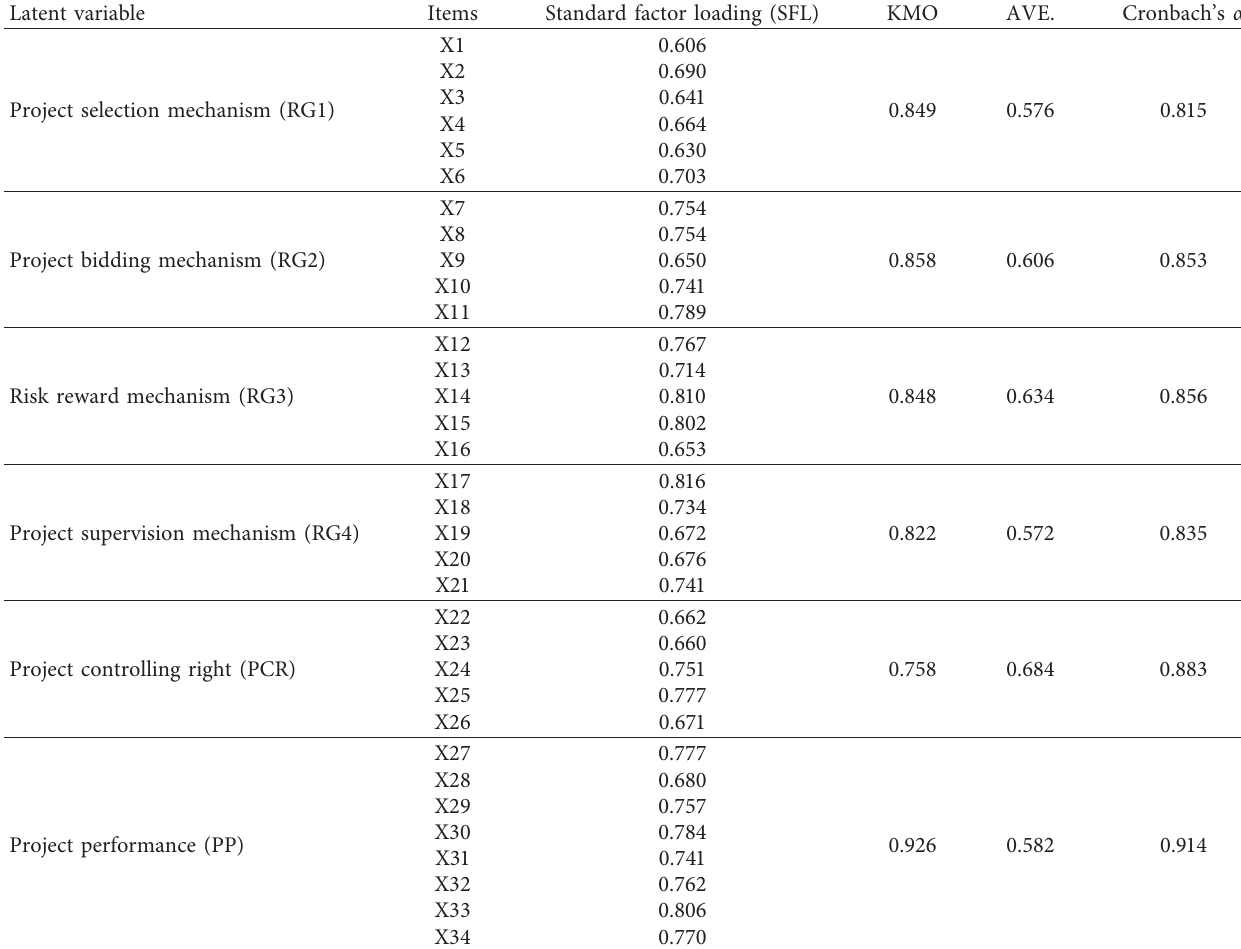
Table 2: Results of validity and reliability of latent